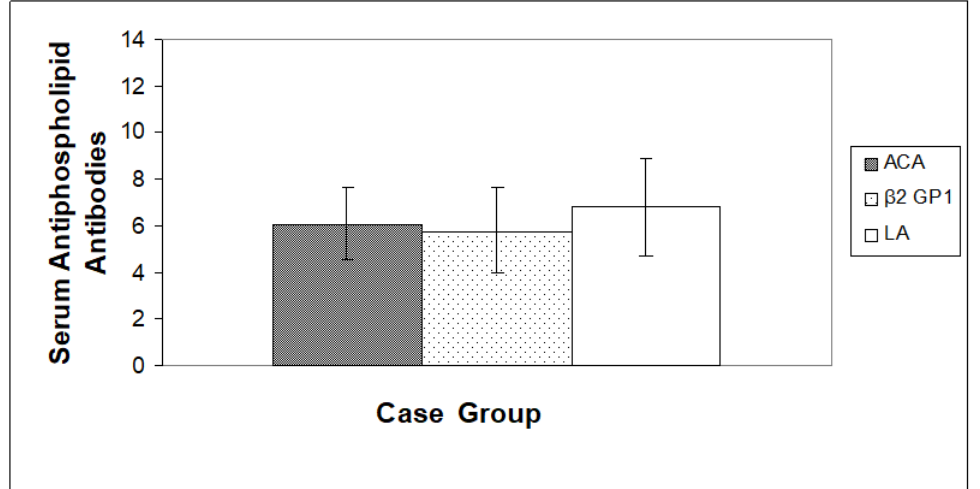
Figure 2. Estimation of anticardiolipin (ACA), anti- β 2-glycoprotein-1 ( β 2 GP1) and Lupus anticoagu- lants (LA) in the case group of Saudi women. Values are Mean ± SD, ( n = 100), n = Total number of subject